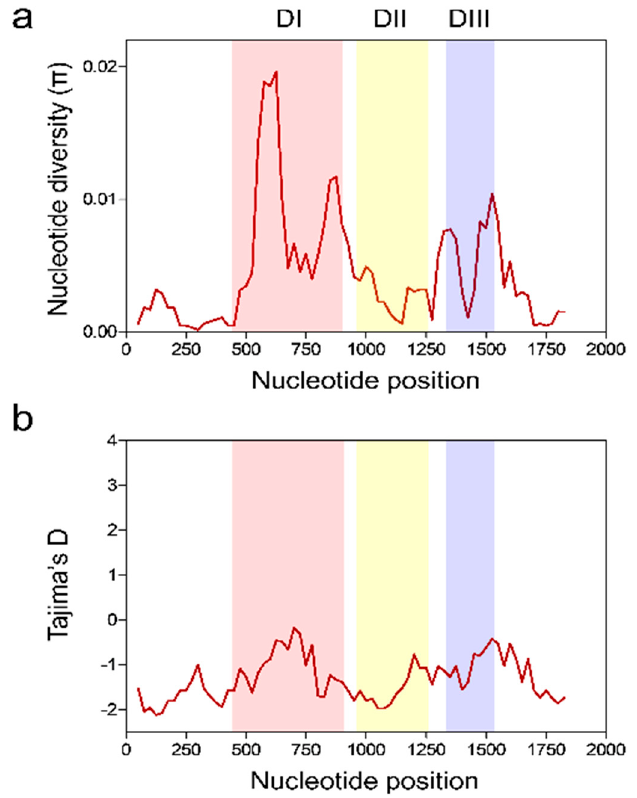
Figure 4. Nucleotide diversity and natural selection of Vietnamese pfama-1 . ( a ) Nucleotide diversity. Sliding window plot showed nucleotide diversity ( π ) values across Vietnamese pfama-1 sequences. A window size of 100 bp and a step size of 25 bp were applied. ( b ) Natural selection. Sliding window plot of Tajima’s D was analyzed for Vietnamese pfama-1 . A window size of 100 and a step size of 25 were applied. DI, domain I; DII, domain II; DIII, domain III.